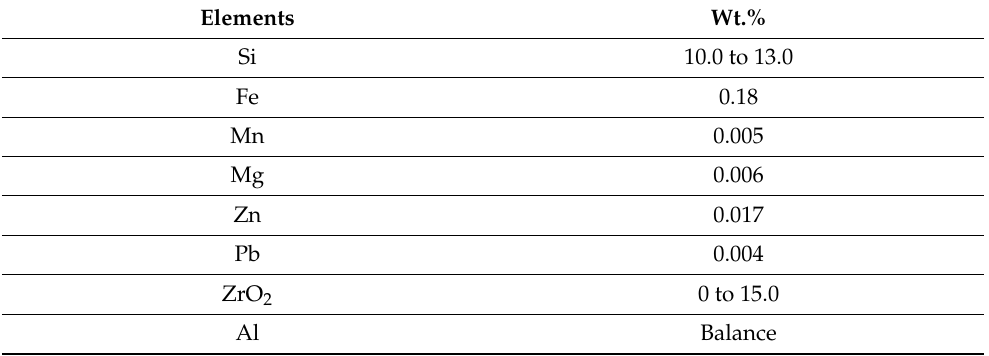
Table 1. Chemical composition of zirconium dioxide reinforced with aluminum silicon